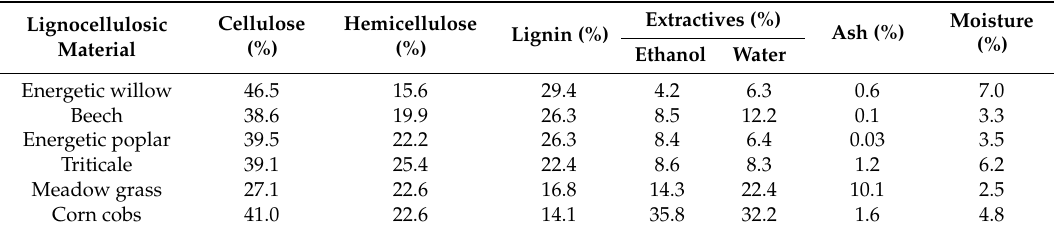
Table 3. Composition of investigated